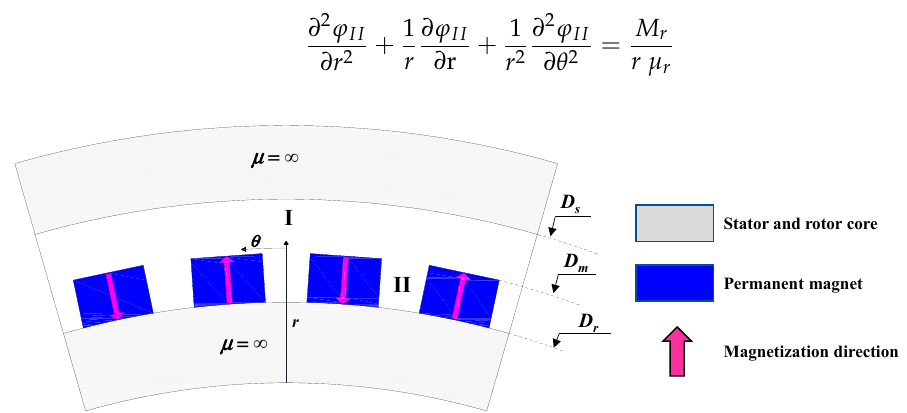
Figure 2. Simplified model for space harmonic analysis.